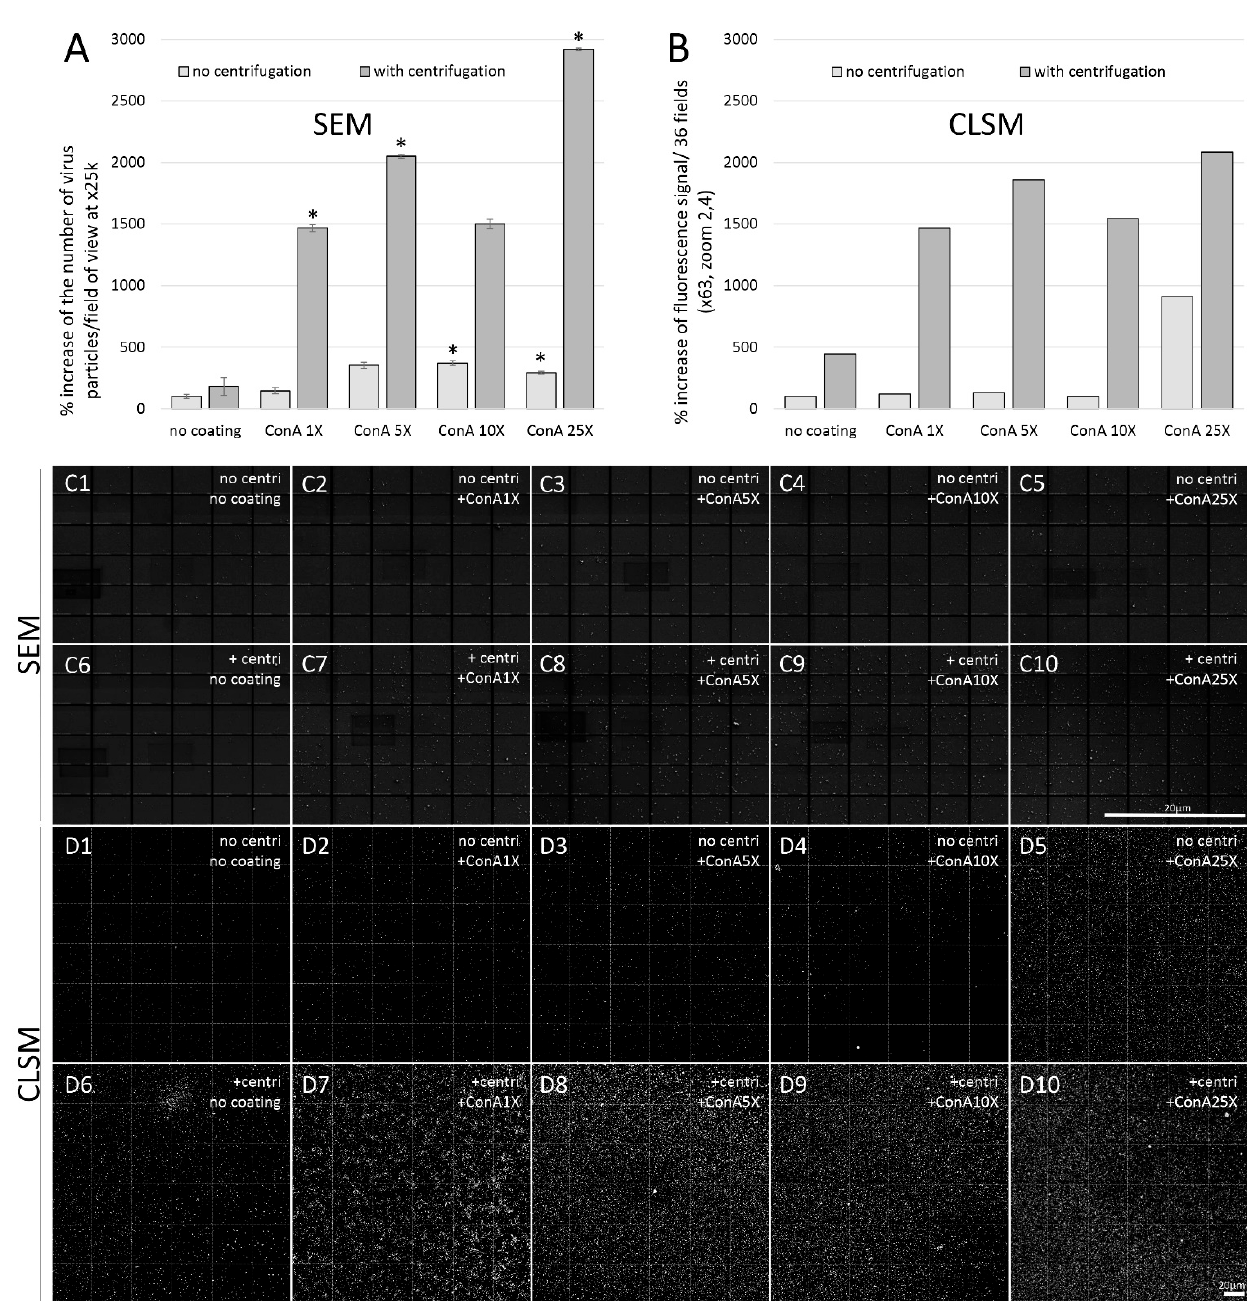
Figure 5. Quantification of the amount of SARS-CoV-2-like particles by SEM ( A ) and of fluorescence signal after anti-SARS-CoV-2 immunostaining by CLSM (B) and respective corresponding images ( C , D ). Deposition of SARS-CoV-2-infected cell culture supernatants after +/ − centrifugation on non- coated slides and slides coated with 1X, 5X, 10X and 25X ConA. C1 – C10 : SEM 6 × 6 mosaic images at x25k magnification; D1 – D10 : binary CLSM 6 × 6 mosaic images at x63/zoom 2.4 magnification after threshold. Error bars represent standard deviations. *: p -value<0.05, Student’s t -test. Scale bars in C10 , D10 for SEM and CLSM images, respectively.